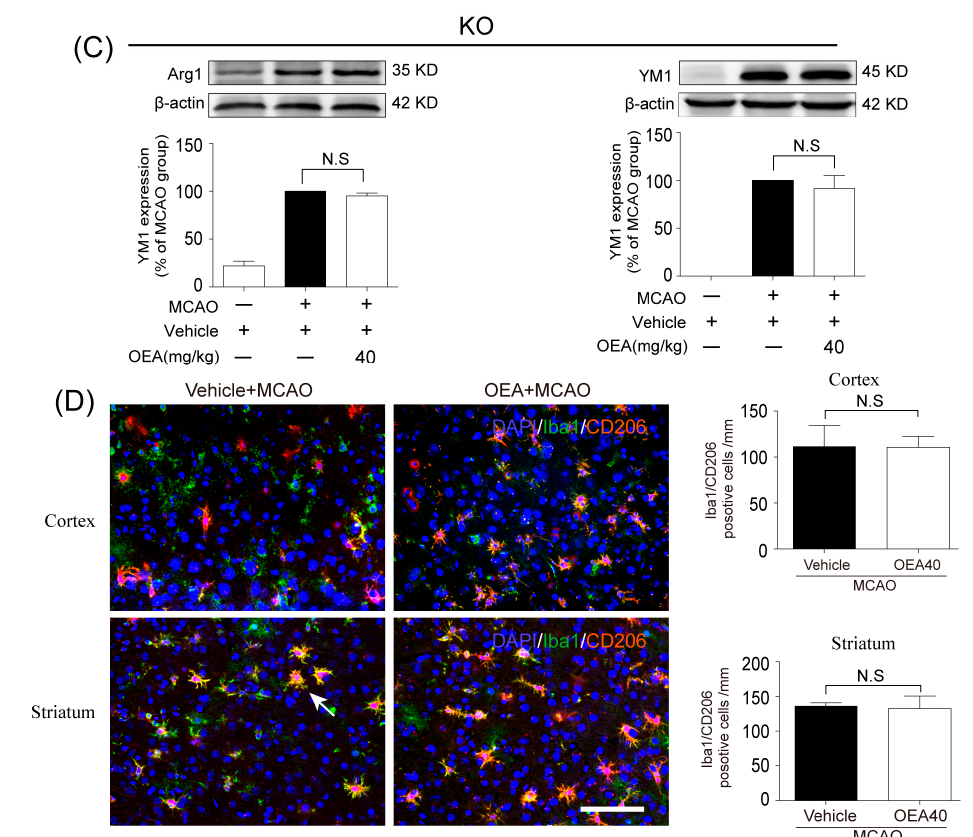
Figure 2. OEA treatment enhances microglia M2 polarization in the injured cortex and striatum in WT but not KO mice at 3 days after MCAO. ( A ) Representative western blot images and quantitative analysis of the expression levels of Arg1 and YM1 in injured brain tissue of WT mice on day 3 after MCAO. ( B ) Representative immunofluorescence images and quantification of CD206 and Iba-1 in the peri-infarction of WT mice on day 3 after MCAO (Iba1 + /CD206 + cells were shown by white arrow). ( C ) Representative western blot images and quantitative analysis of the expression levels of Arg1 and YM1 in injured brain tissue of KO mice on day 3 after MCAO. ( D ) Representative immunofluorescence images and quantification of CD206 and Iba-1 in the peri-infarction of KO mice on day 3 after MCAO (Iba1 + /CD206 + cells were shown by white arrow). The data are the means ± SEM. n = 5 per group. ## p < 0.01, ### p < 0.001 vs. vehicle + sham; * p < 0.05, ** p < 0.01, *** p < 0.001 vs. MCAO + vehicle group; N.S = No Significance. Scale Bar = 100 µ